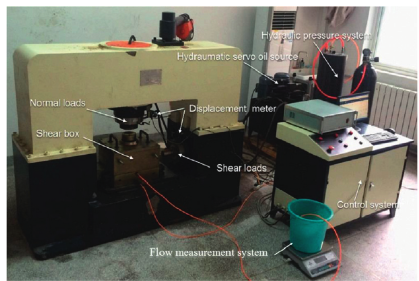
Figure 1: TJXW-600 hydromechanical coupling test